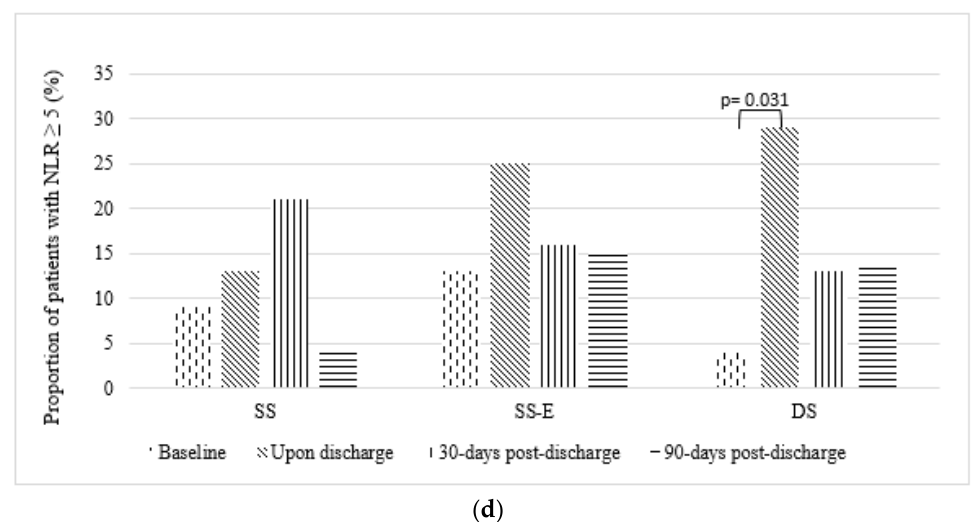
Figure 3. Changes in the proportion of patients with ( a ) CAR ≥ 0.1, ( b ) mGPS score 1 or 2, ( c ) mPINI ≥ 0.4 and ( d ) NLR ≥ 5. p value indicated significance within groups between timepoints determined by McNemar test.